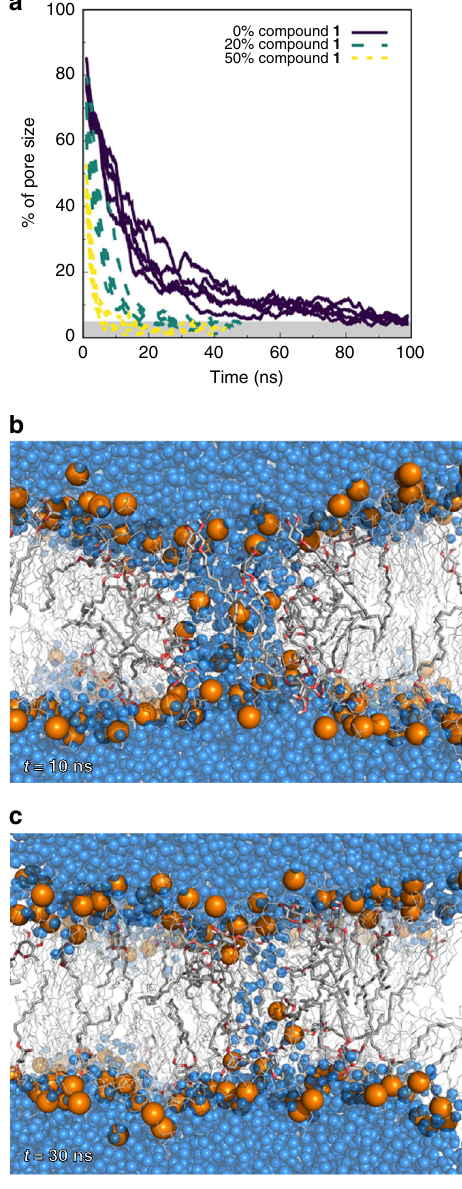
Fig. 4 Effect of compound 1 on the stability of pre-formed membrane pores. a Estimated size of pre-formed membrane pores over time without external surface tension. The fi ve replicates of each system, namely pure DMPC (control) and mixtures containing ~ 20% or 50% of compound 1 are presented. A full pore corresponds to a region with ~ 1800 water molecules between lea fl ets. The gray region represents very small pore sizes and, in many cases, complete closure of the pore. Pore size was estimated using the number of water molecules in the interior of the transmembrane cavity. The data are shown as a fl oating window average (2 ns) for clarity. A graphical representation of b a large pore and c a small pore is also shown for a 20% molar ratio mixture. DMPC molecules are shown as thin lines while those of compound 1 are shown as thicker sticks. Water molecules and phosphorus atoms are shown as blue and orange spheres,